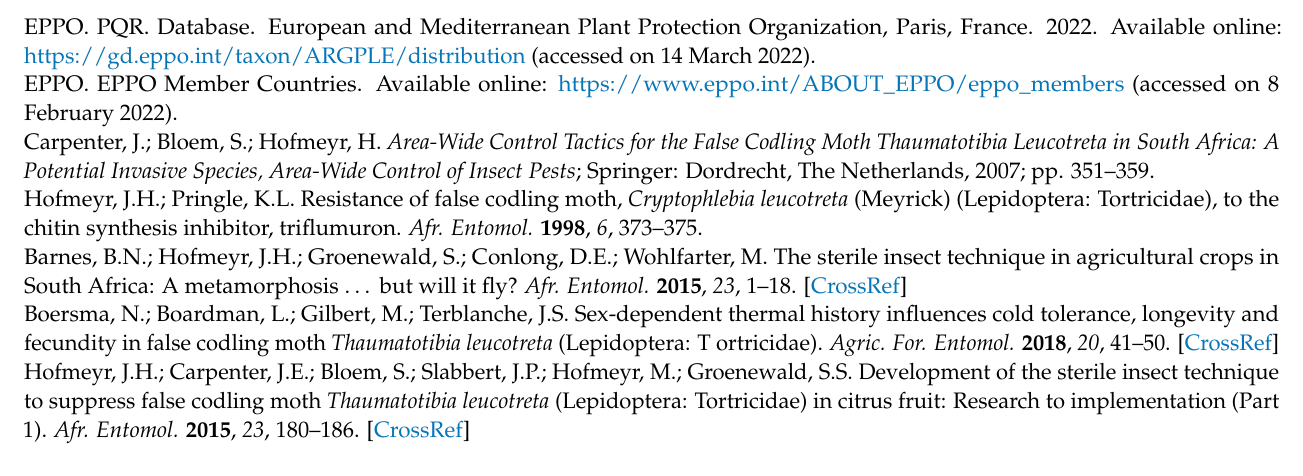
at: Figure S1: (a) Wing venation of Thaumatotibia leucotreta adapted from [65] (D-discal cell; M- Media, R-Radius, Sc-Subcosta; CuA1-1st anterior cubitus; CuA2-2nd anterior cubitus; CuP-posterior cubitus) (b) overall and (c) zoomed picture of a T. leucocreta wing indicating the areas used as a measure of wing width (WW) and wing length (WL). Figure S2 : Correlation matrix comparing the morphological parameters (mass, wing width (Width), wing length (Length), wing area (Wing area), wing loading (WL) and aspect ratio (AR)) measured from false codling moth (FCM) that underwent flight performance tests after developmental thermal acclimation. Positive numbers represent positive correlations and negative numbers represent negative correlations. Larger and darker circles represent significant